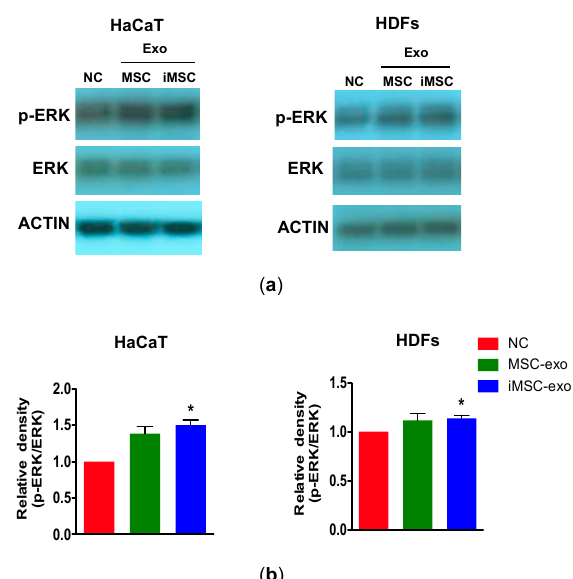
Figure 6. Immunoblotting for the detection of phosphorylated ERK1/2 in HaCaT and HDFs. ( a ) Cells were cultured with MSC-exo or iMSC-exo for 1 h and then the cell extracts were analyzed by immunoblotting for total ERK1/2 and phosphorylated ERK1/2 (Thr202/Tyr204). Beta-actin was used as the loading control. NC and PC are cells cultured without and with serum, respectively. ( b ) Densitometric analysis of the relative level of phosphorylated ERK1/2 (Thr202/Tyr204) against their total levels in HaCaT and HDFs. The value was normalized against that observed for negative control (NC, no serum). All data are expressed as mean ± standard deviation (SD) from three replicates. * p < 0.05 against NC. HDFs indicate human postnatal dermal fibroblasts.